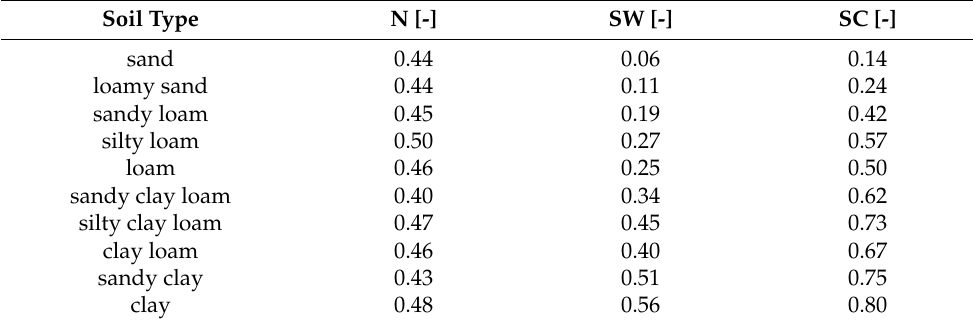
Table 2. The SMAR parameters for different soil texture [37,51].